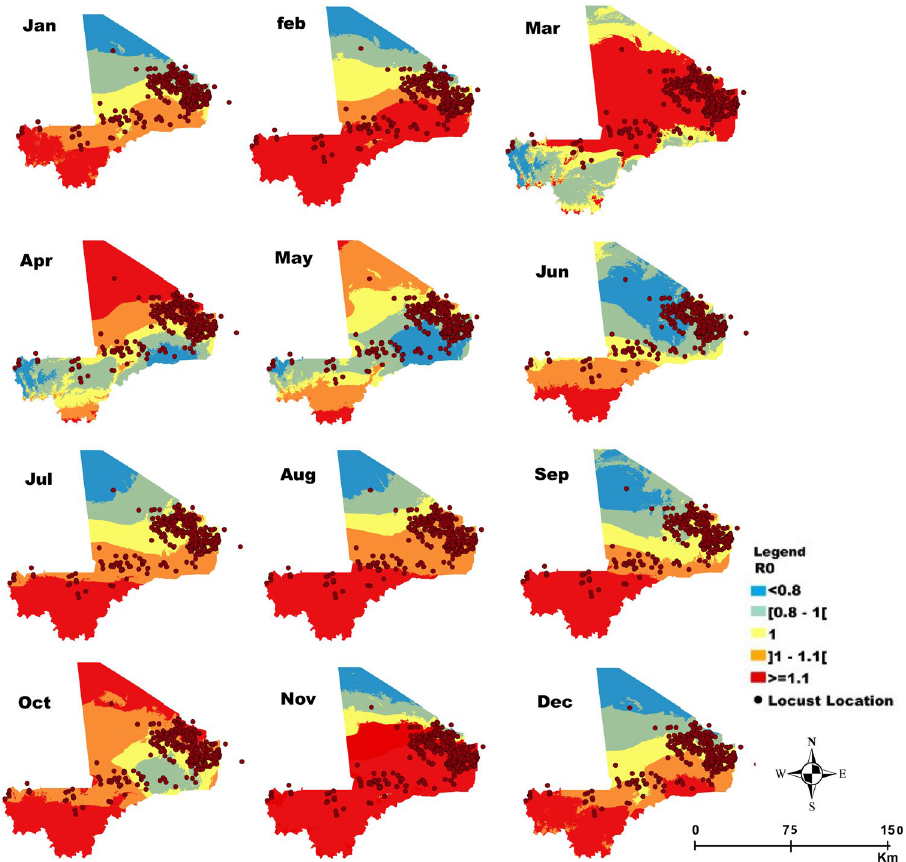
Figure 4. Mali: Monthly spatial projection of the variation in R 0 as a function of temperature and relative humidity reflecting the potential efficiency of the entomopathogenic fungus Metarhizium acridum as a biocontrol agent against locusts. The area in red in each month are areas where R 0 > 1 correspond to zones with potential higher efficiency and hence fungal biocontrol agent application against locusts while the area in brown ( R 0 ≈ 1) can also been targeted but with less potential efficacy. Application in areas in yellow and blue ( R 0 < 1) will probably not be efficient. The dots correspond to the reported point incidence of locusts in